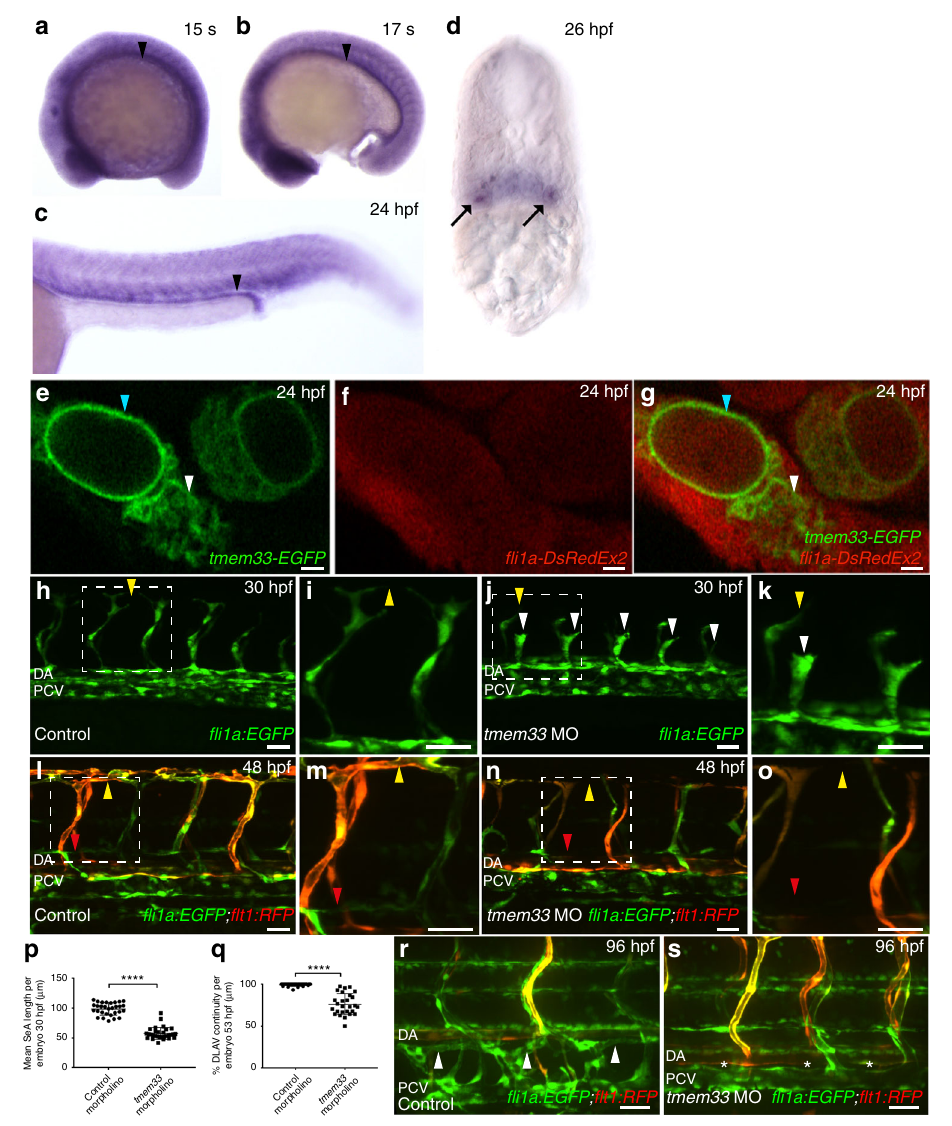
Fig. 1 tmem33 knockdown inhibits angiogenesis and localises to the ER in ECs. a – d tmem33 is expressed ubiquitously during segmentation, but displays enrichment in the pronephros (black arrowheads) and somite boundaries, which is more pronounced from 24 hpf. Pronephric expression is evident in 26 hpf transverse sections (black arrows). e – g Tmem33-EGFP protein localises to the nuclear envelope (blue arrowheads) and ER (white arrowheads) within the caudal artery in fl i1a:DsRedEx2 embryos (Scale bars 1 µ m). h – k tmem33 morphants injected with 0.4 ng morpholinos display delayed migration of Tg ( fl i1a:egfp) positive SeAs, which stall at the horizontal myoseptum ( j , k , white arrowheads), compared with control Tg( fl i1a:egfp) positive morphants ( h , i ), which begin to anastomose by 30 hpf (yellow arrowheads) (scale bars 50 µ m). l – o By 48 hpf, Tg( fl i1a:EGFP; − 0.8 fl t1:RFP) tmem33 morphant SeAs complete dorsal migration, but display incomplete DLAV formation ( n , o , yellow arrowheads) and lack lymphatic vasculature (red arrowheads). At 48 hpf Tg( fl i1a: EGFP; − 0.8 fl t1:RFP) control morphants display secondary angiogenesis ( l , m , yellow arrowheads) and parachordal lymphangioblasts (red arrowhead) (scale bars 50 µ m). p tmem33 morphants injected with 0.4 ng morpholinos display reduced SeA length at 30 hpf ( t -test **** p = < 0.0001; t = 4.075; DF = 24. n = 3 repeats, 10 embryos per group). q tmem33 morphants injected with 0.4 ng morpholinos display incomplete formation of DLAV ( t -test **** p = < 0.0001; t = 5.618; DF = 28. n = 3 repeats, 9 or 10 embryos per group). r , s Thoracic duct formation is impaired in tmem33 morphants injected with 0.4 ng morpholinos (white asterisks), compared with control morphants (white arrowheads) (scale bars 50 µ m). DA, dorsal aorta; PCV, posterior cardinal vein. Source data are provided as a Source Data fi